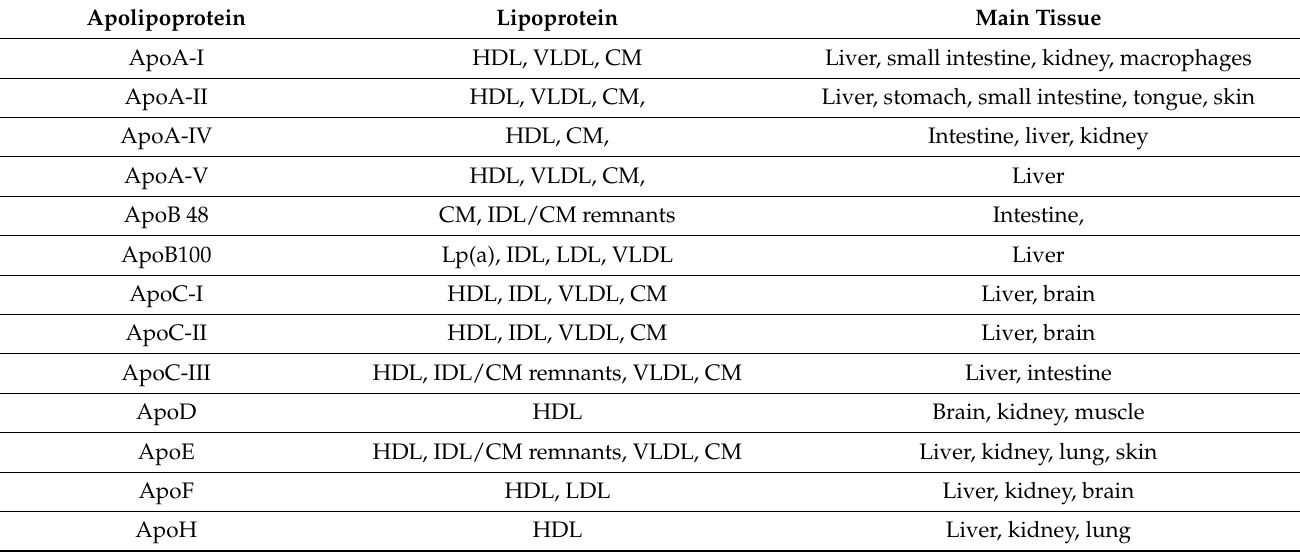
Table 1. Apolipoprotein tissue distribution and lipoprotein